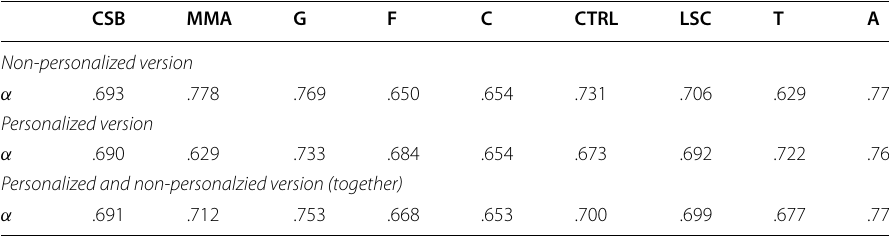
Table 3 Internal reliability for the